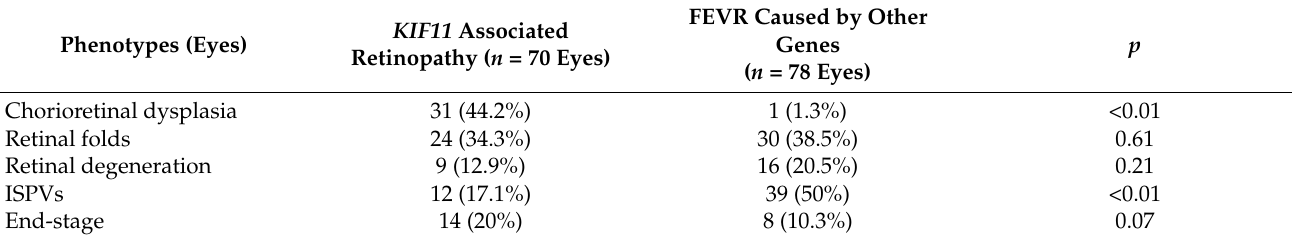
Table 3. Comparison of KIF11 associated retinopathy and FEVR caused by other genes ( FZD4, TSPAN12, LRP5, NDP and JAG1